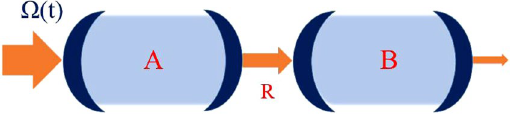
Figure 1. A cascaded Kerr photon blockade system under a coherent driven